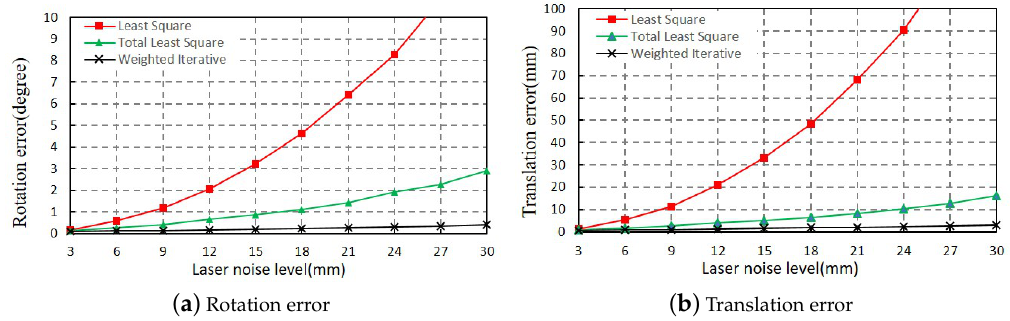
Figure 7. Calibration error of extrinsic parameters between two LRFs: ( a ) Rotation error and ( b ) translation error.